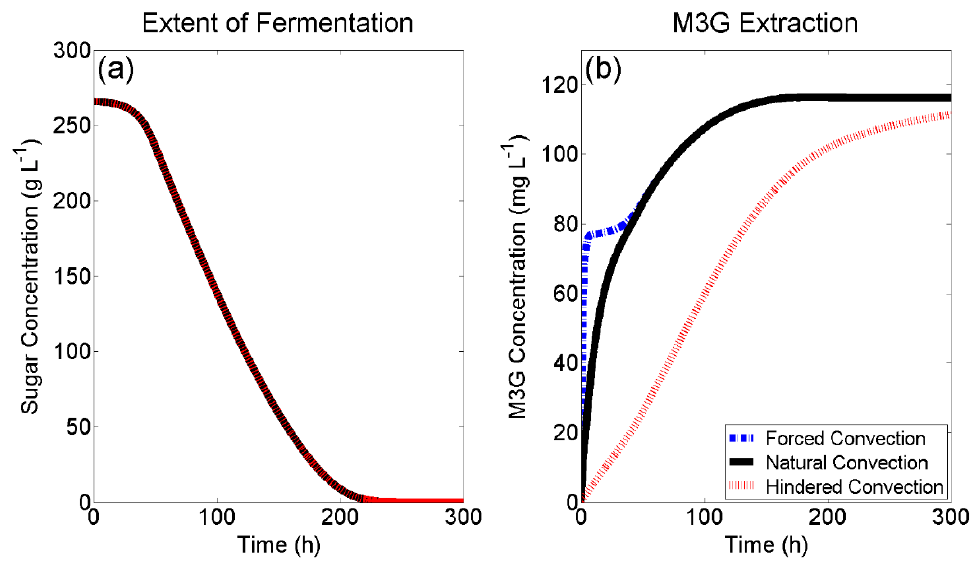
Figure 4. ( a ) Simulated red wine fermentation kinetics and ( b ) the resulting simulated extraction kinetics of M3G under different modes of liquid phase convection.